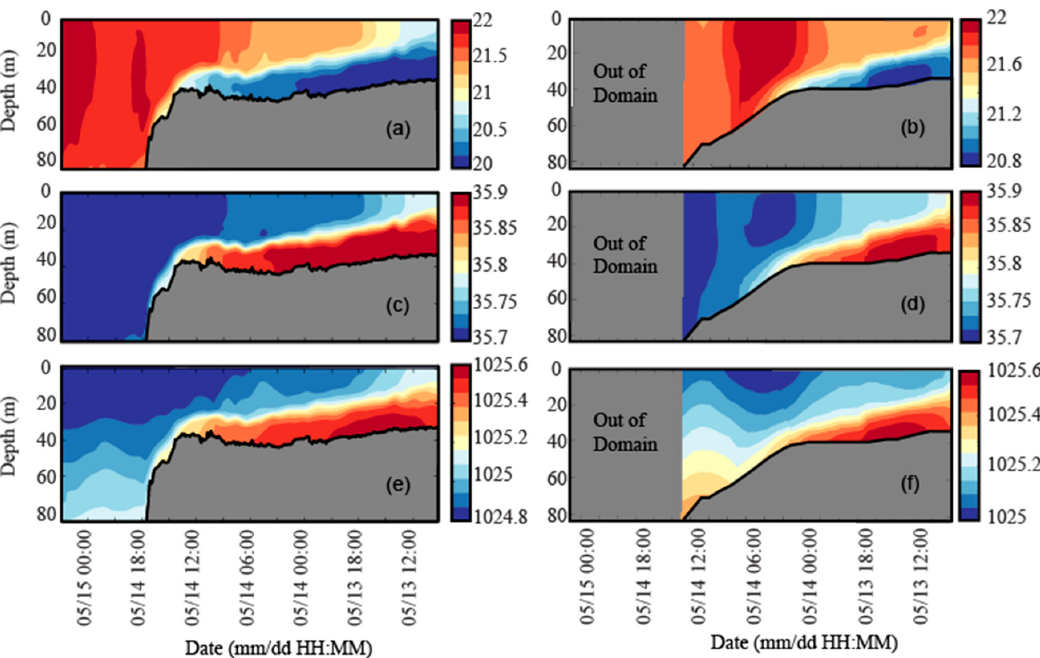
Figure 4. Comparison between observed ( a ) temperature (°C), ( c ) salinity (psu), and ( e ) density (kg/m 3 ) distribution along the Two Rocks transect obtained from ocean glider data and ( b , d , f ) those predicted from ROMS simulation over May 13–15, 2016.